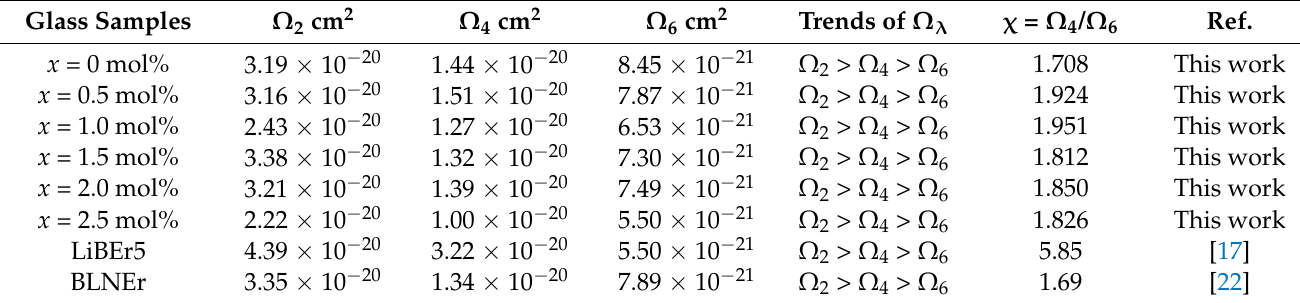
Table 4. Judd–Ofelt intensity parameters and spectroscopic quality factors for all prepared glass samples. Glass